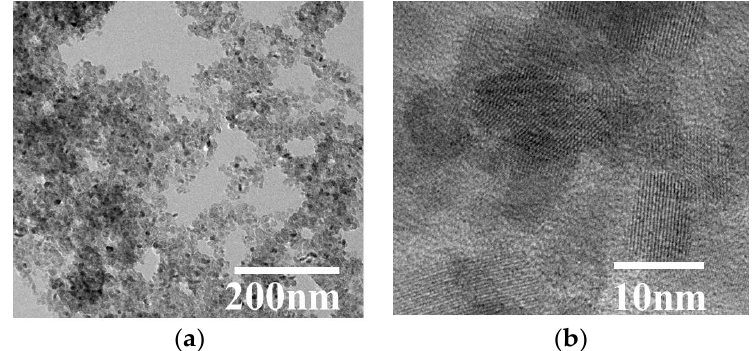
Figure 4. ( a ) The TEM image and ( b ) HRTEM image of RCP-AG(15).